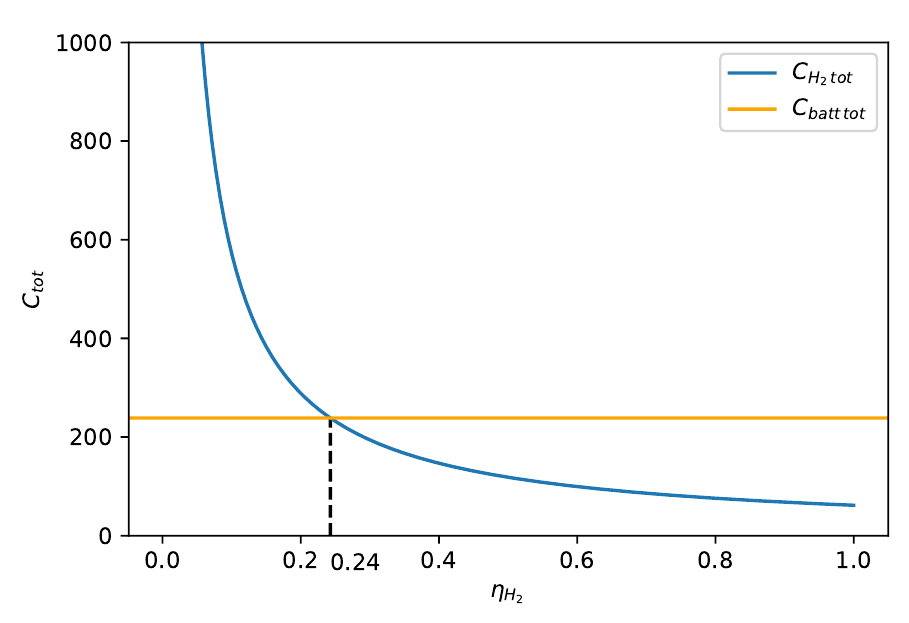
Figure 5. The total hydrogen storage impact depending on the efficiency of